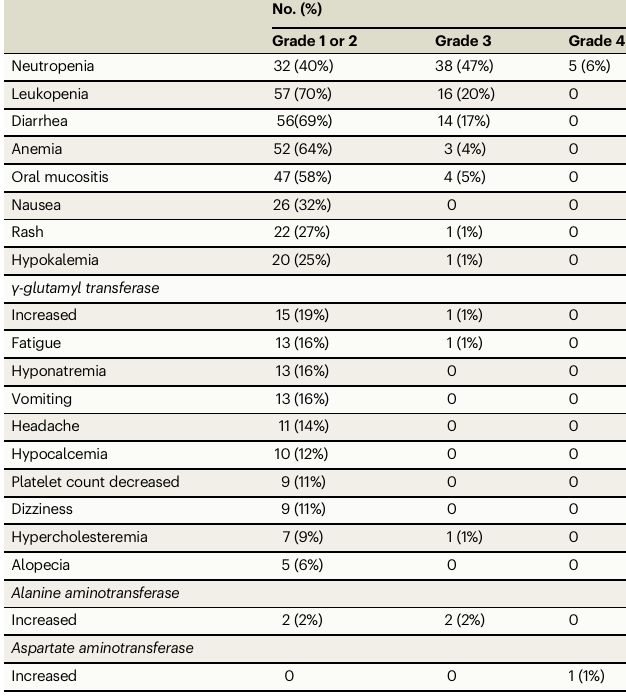
Table 3 | Treatment-emergent adverse events in patients ( n = 81)